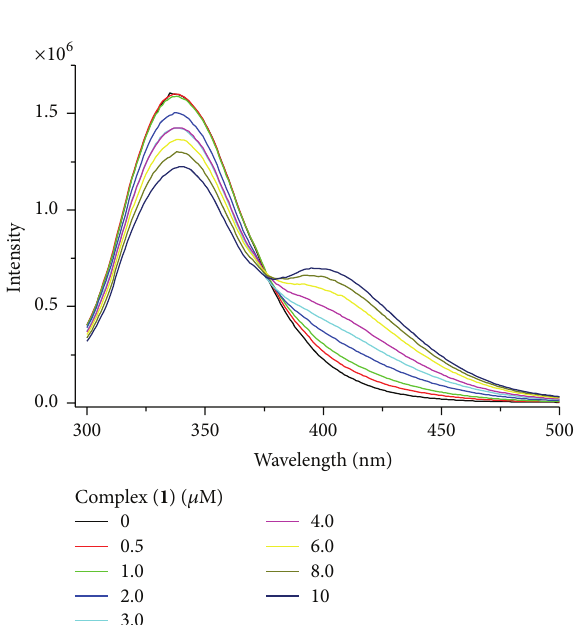
Figure 4: Fluorescence spectra of BSA (4 𝜇 molL −1 ) in the absence and presence of increasing amounts of [CuCl(bipy)(NOR)]Cl ( 1 ).